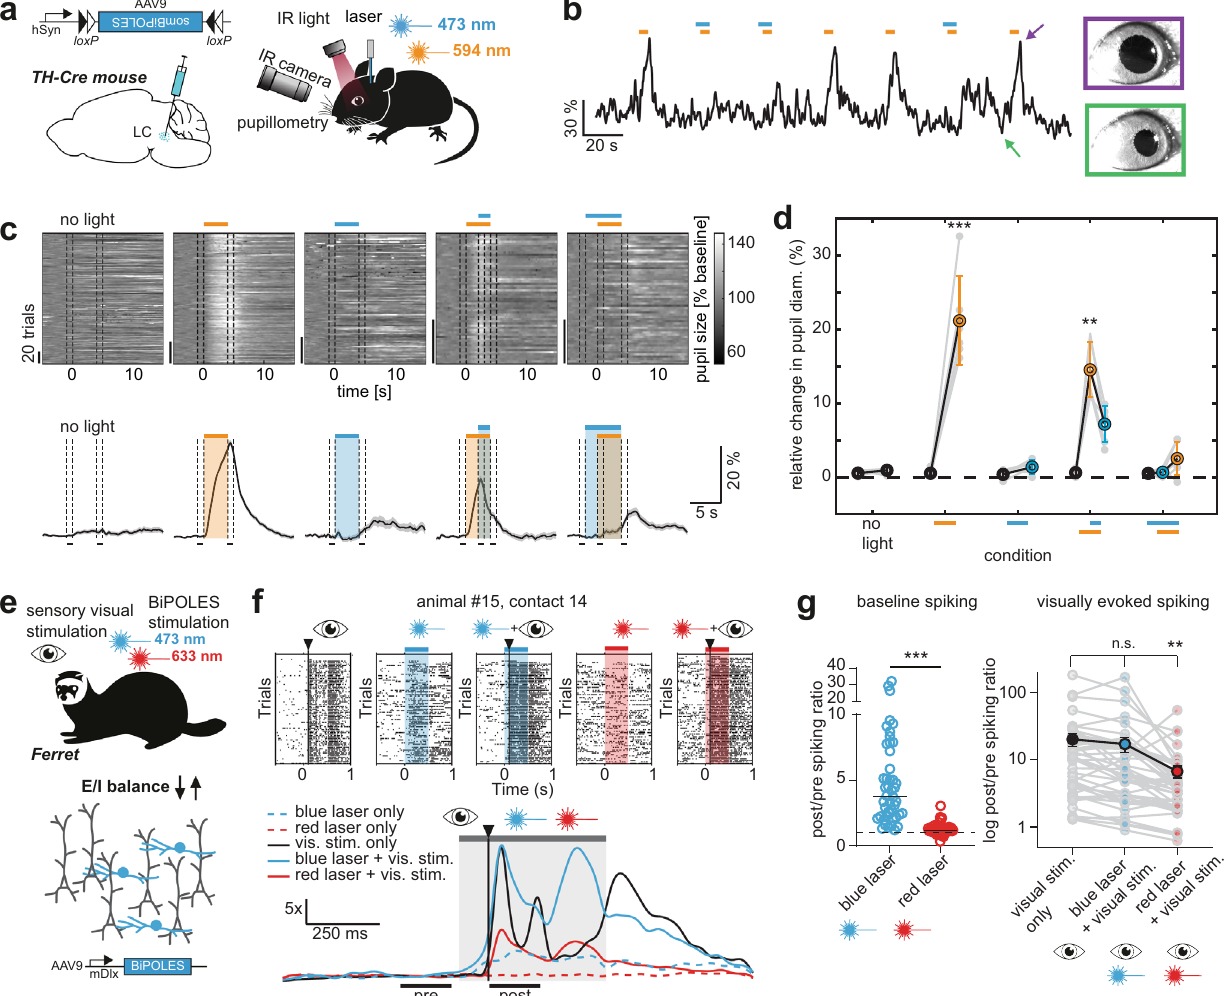
Fig. 7 BiPOLES and somBiPOLES allow bidirectional modulation of neuronal activity in mice and ferrets. a Conditional expression of somBiPOLES in Cre- positive neurons of the TH-Cre mouse to modulate pupil dilation. b Relative pupil diameter in single trials. Orange and blue bars indicate the time of illumination with 594 (orange) and 473 nm (blue), respectively. Arrows indicate positions of the two example images of the eye. c Quanti fi cation of normalized pupil size in one animal under various stimulation conditions for somBiPOLES as indicated. Top: single trials. Bottom: mean± SEM. Dashed lines show time windows used for quanti fi cation in the plot on the right. d Quanti fi cation of relative pupil size ( n = 6 mice; One-way analysis of variance; F = 61.67, p = 1.36 × 10 − 12 ; Tukey ’ s multiple comparison test: ** p = 0.0028, *** p < 0.0001). e Modulation of GABAergic neurons (blue) in ferret secondary visual cortex (area 18) with mDlx-BiPOLES. Red (633 nm) or blue (473 nm) laser light was used to (de-)activate interneurons with or without a following 10- ms visual fl ash (white LED; Osram OSLON Compact) to the ferret ’ s right eye. f Example neuronal spiking responses at one contact of the linear probe (~700 µ m depth) under indicated stimulation conditions Top: Raster-plots of the visual stimulus alone, blue laser ( + visual), red laser ( + visual) conditions. Bottom: Normalized to ‘ pre ’ -phase averaged spike-density plot (sigma = 20ms) of each indicated condition. Gray area: laser-on epoch; black vertical line: visual stimulus onset. Black horizontal lines indicate the 200ms pre-stim and post-stim analysis epochs to compute the results in g . Note the rate increase after the onset of the blue laser before the onset of the visual stimulus and the reduced answer after red laser illumination. g Spike-rate ratio of post vs. pre-laser- stimulus epoch. Left: quanti fi cation of laser-mediated impact on baseline spiking rate (no visual stim.). Right: quanti fi cation of the spike-rate change of the same units during only visual and laser + visual stimulation ( n = 46 contacts showing visual responses from 3 animals, ** p = 0.0046, *** p <